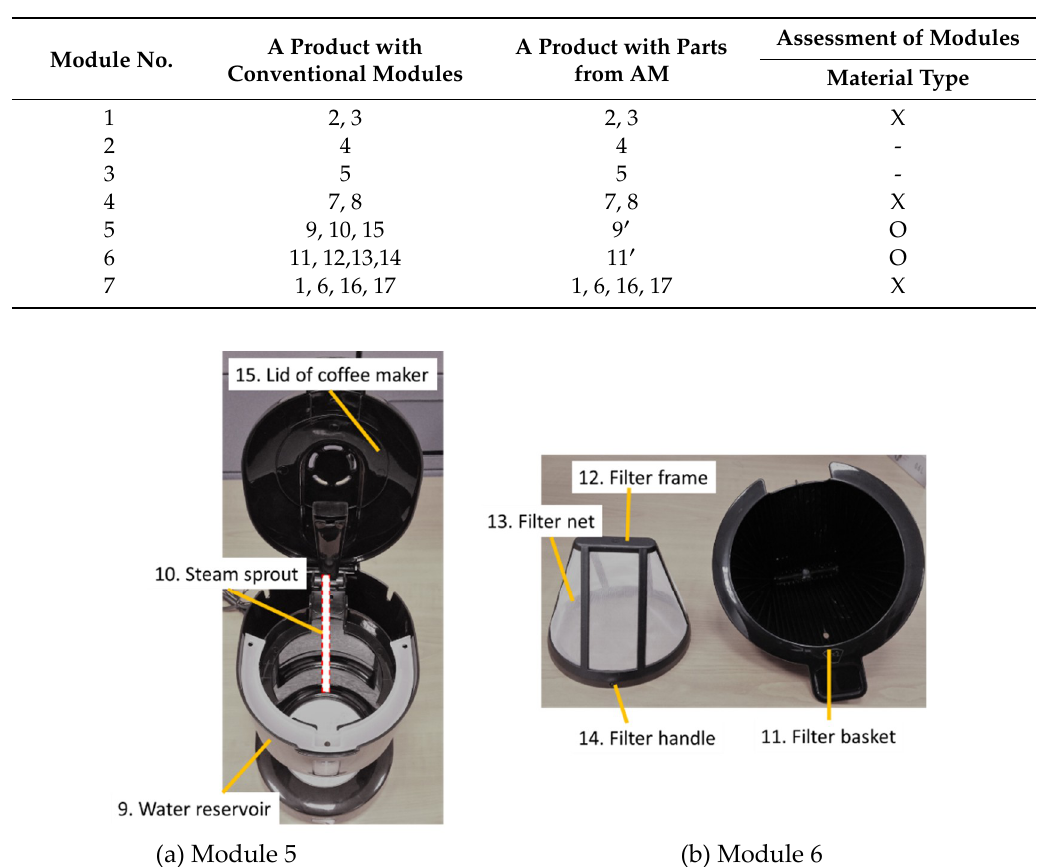
Table 6. Module identification and assessment.